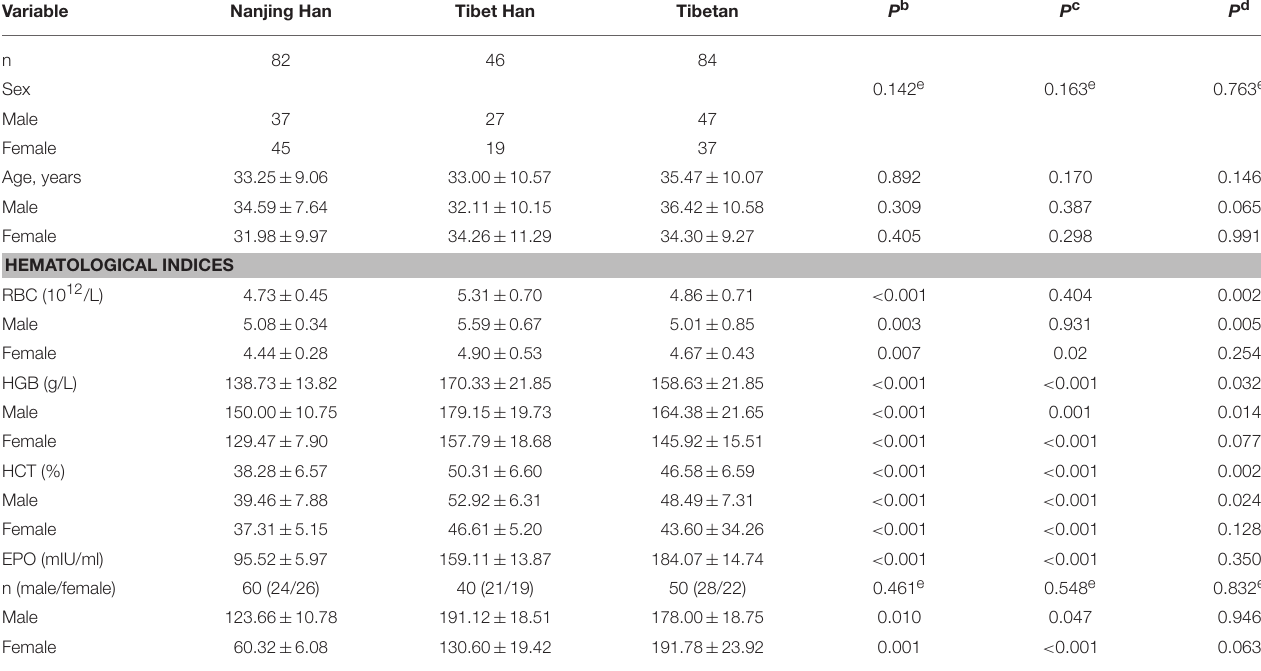
TABLE 1 | Demographic and hematological features of the Nanjing Han, Tibet Han, and Tibetan groups a . Variable Nanjing Han Tibet Han Tibetan